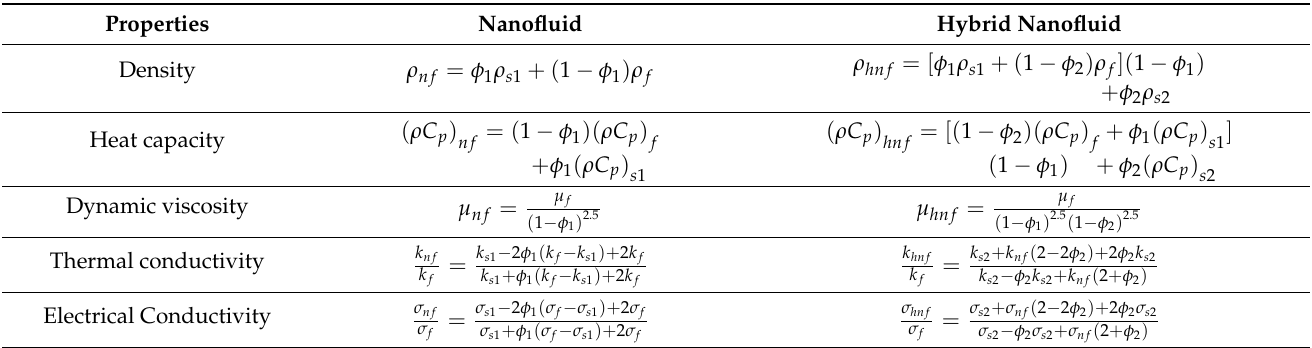
Table 2. Correlations of hybrid nanofluids (refer to Sulochana et al. [17], Madhukesh et al. [22], and Nurul Amira Zamal et al.